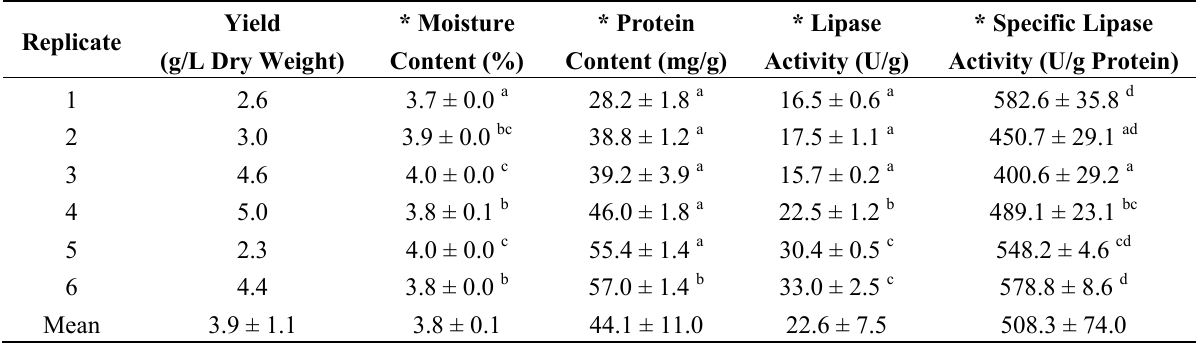
Table 1. Properties and characteristics of MBL from G. candidum